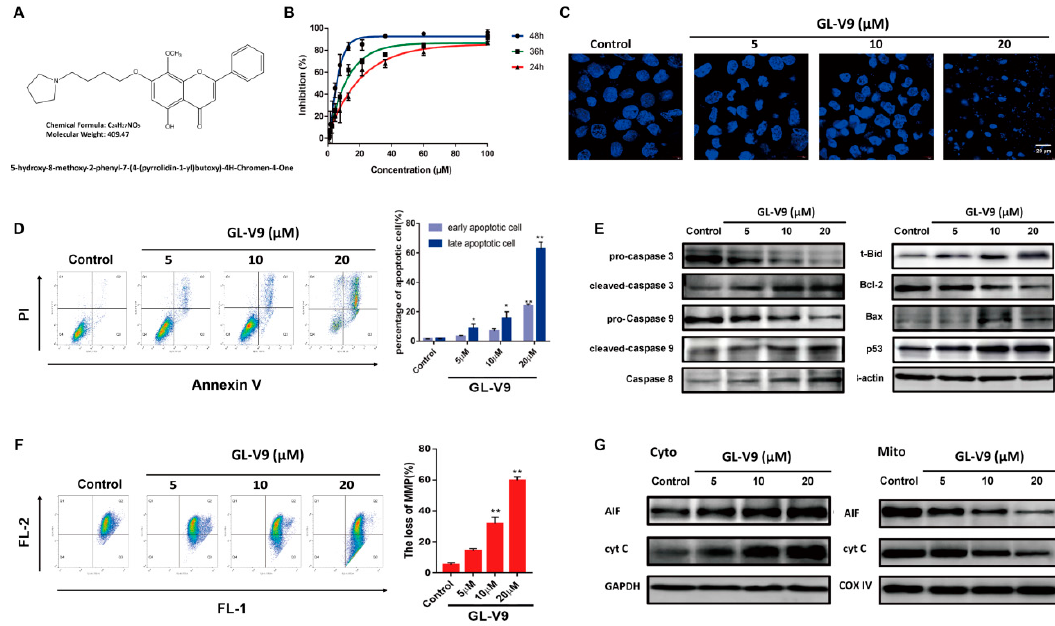
Figure 1. GL-V9 induces apoptosis of A431 cells via mitochondrial mediated pathway. ( A ) The